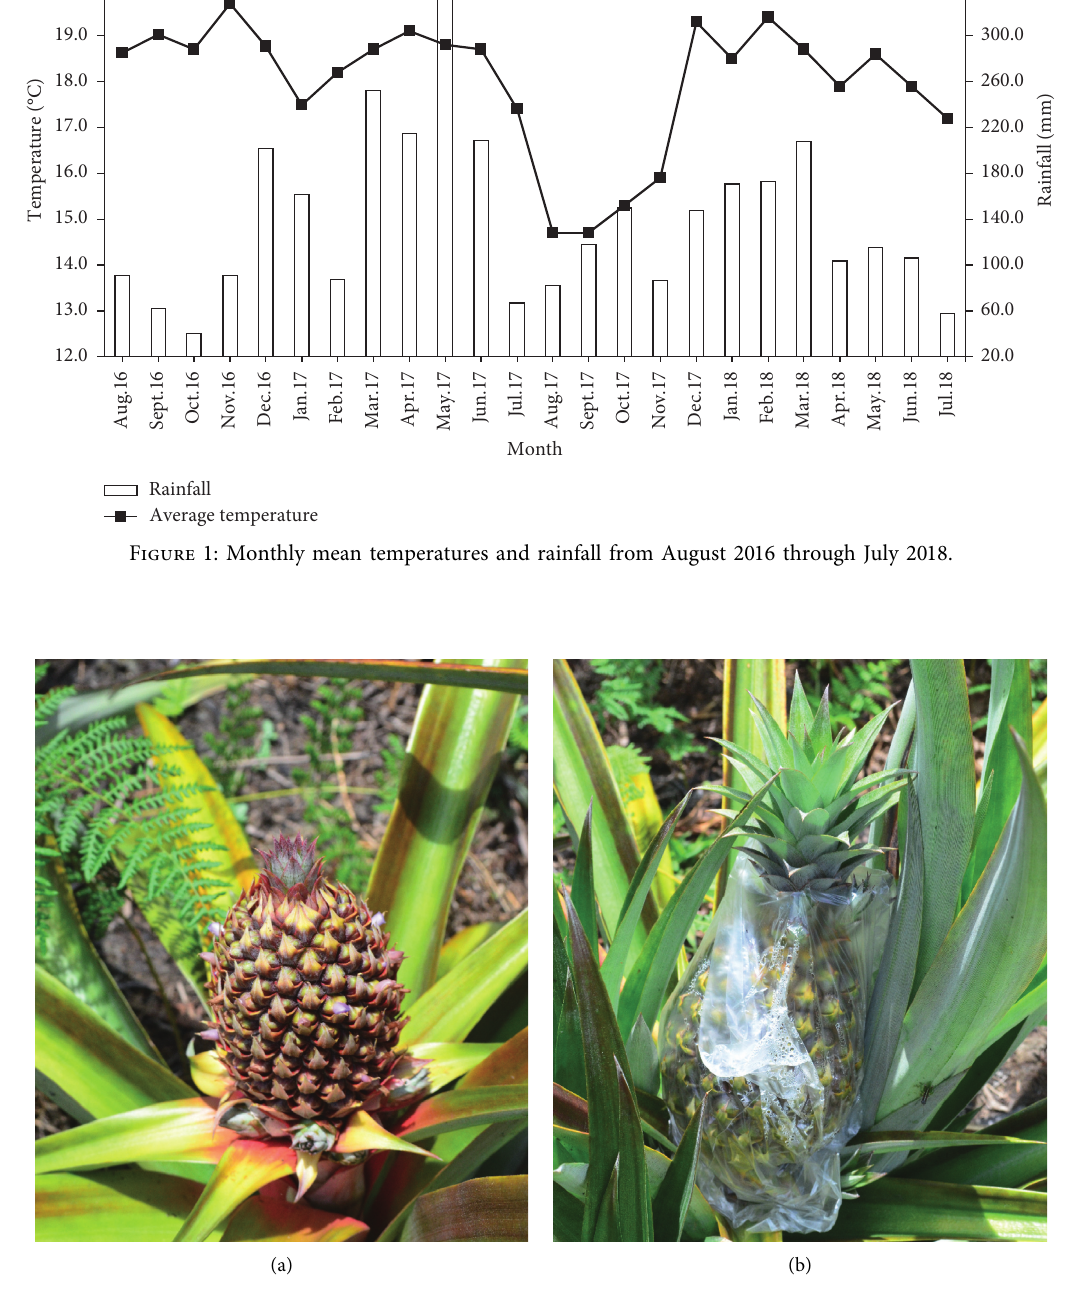
Figure 2: Physical control of fruit flies. (a) Last flowers present prior to the (b) bagging of pineapple fruit.